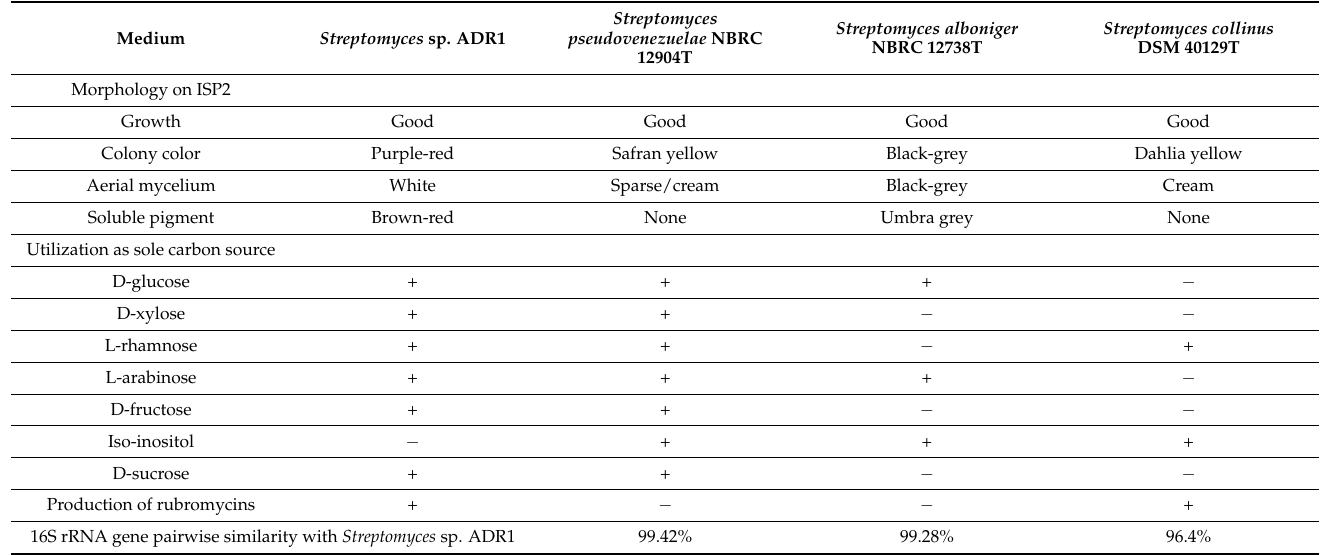
Table 3. Morphological, cultural features and physiologically different characteristics of